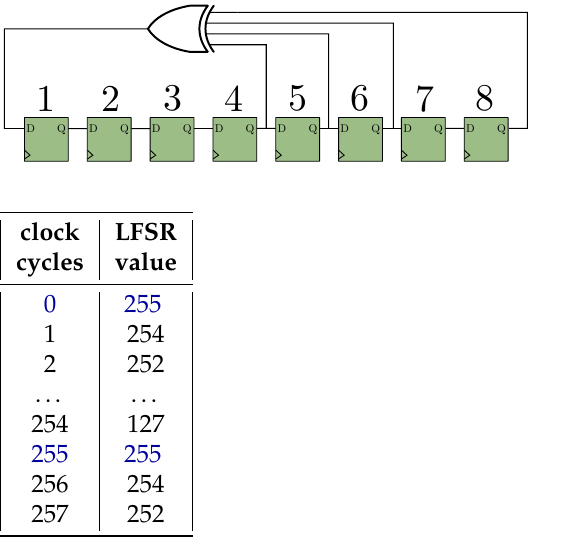
Figure 2. 8-bit LFSR circuit with a primitive polynomial configuration equal to x 8 + x 6 + x 5 + x 4 + 1 (184 in binary notation). Every N = 255 cycles, the sequence is repeated periodically, starting from the seed value (blue